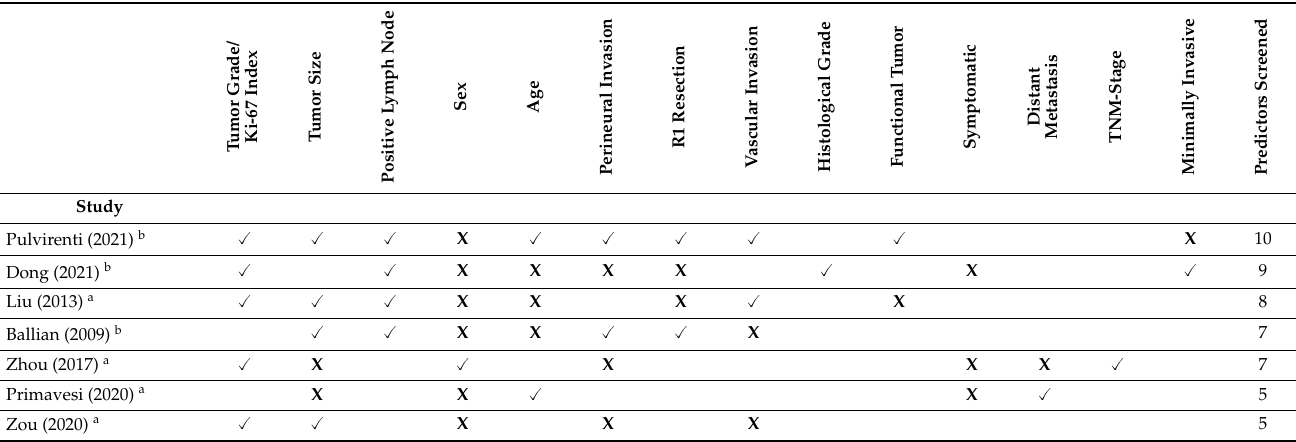
Table 3. Predictor association with recurrence-free